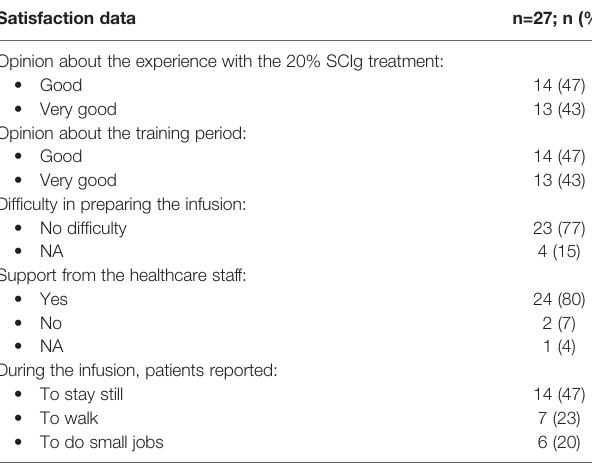
TABLE 4 | Satisfaction data in the 27 PM/DM surviving